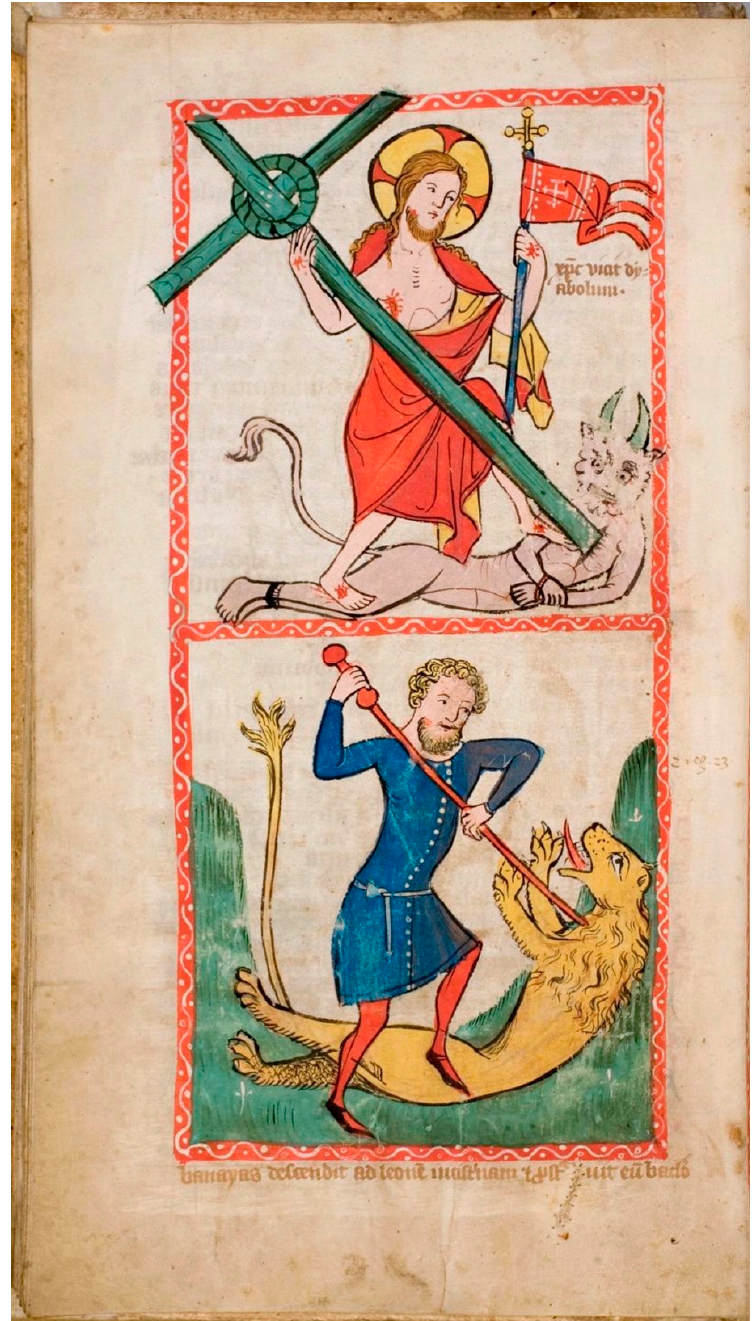
Figure 7. Christ piercing the devil with the cross, facsimile from Speculum Humanae Salvationis , Hs 2505. Germany, ca. 1350. Available at http://tudigit.ulb.tu-darmstadt.de/show/Hs-2505/0108/image.